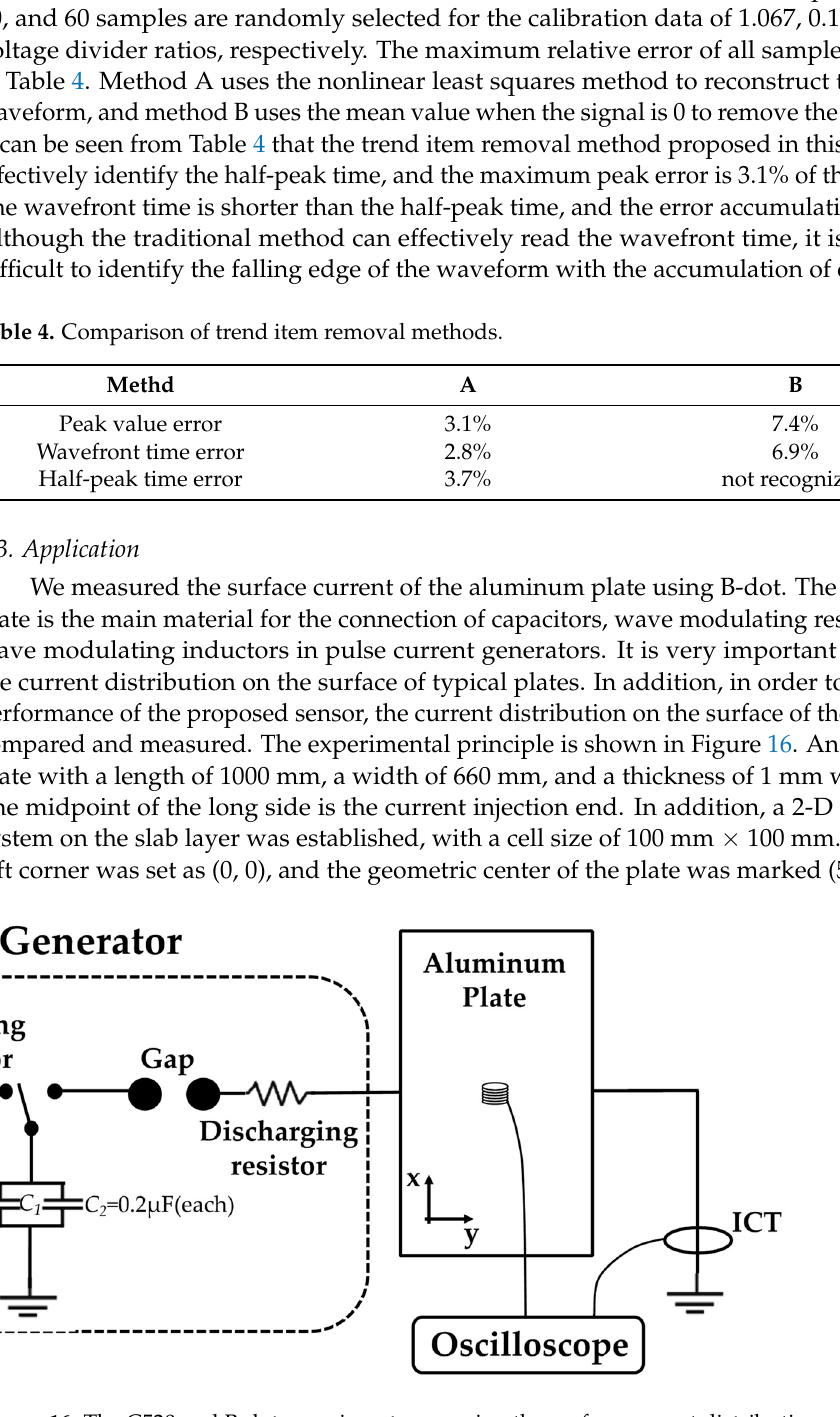
Figure 16. The C520 and B-dot experiment measuring the surface current distribution and magnetic field strength of the aluminum plate.